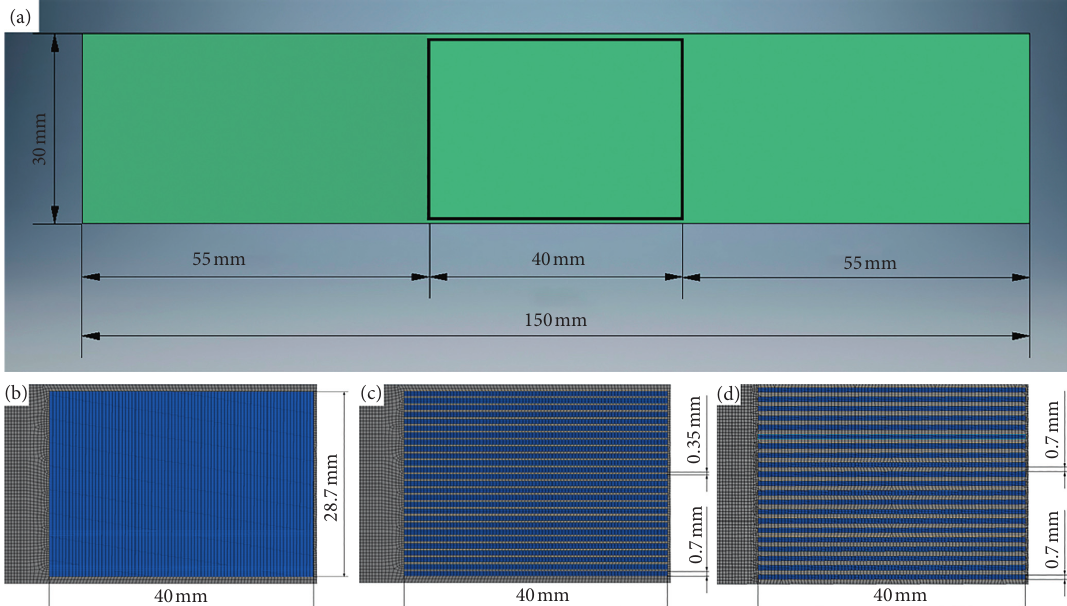
Figure 2: Views of the surface of samples in Ansys software: (a) general view of metal plate with dimensions of treated area. (b) Case B. (c) Case C. (d) Case D.